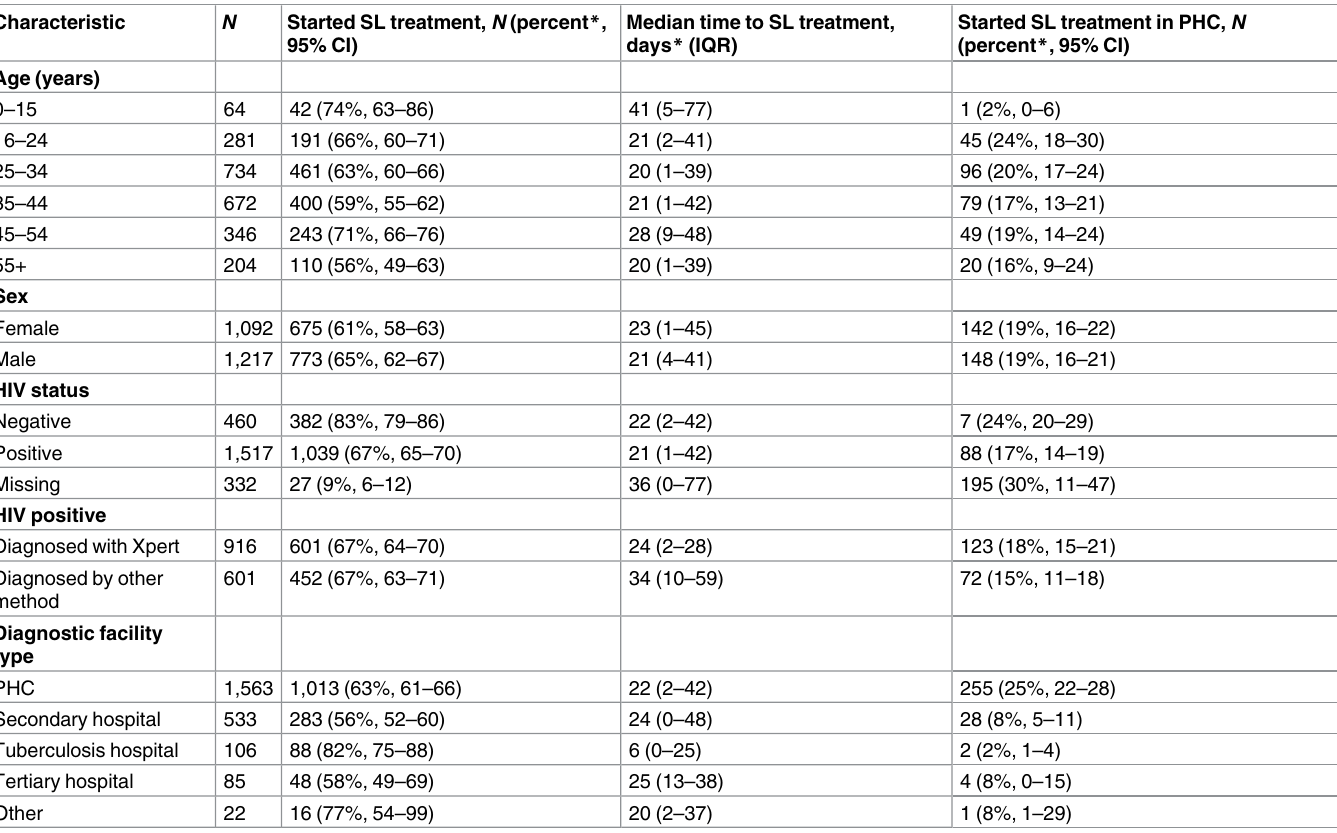
All percentages and times are weighted for sampling method. * All percentages and times are weighted (note that the reported percentages may not match the percentages obtained by dividing the raw numbers due to weighting to account for the sampling